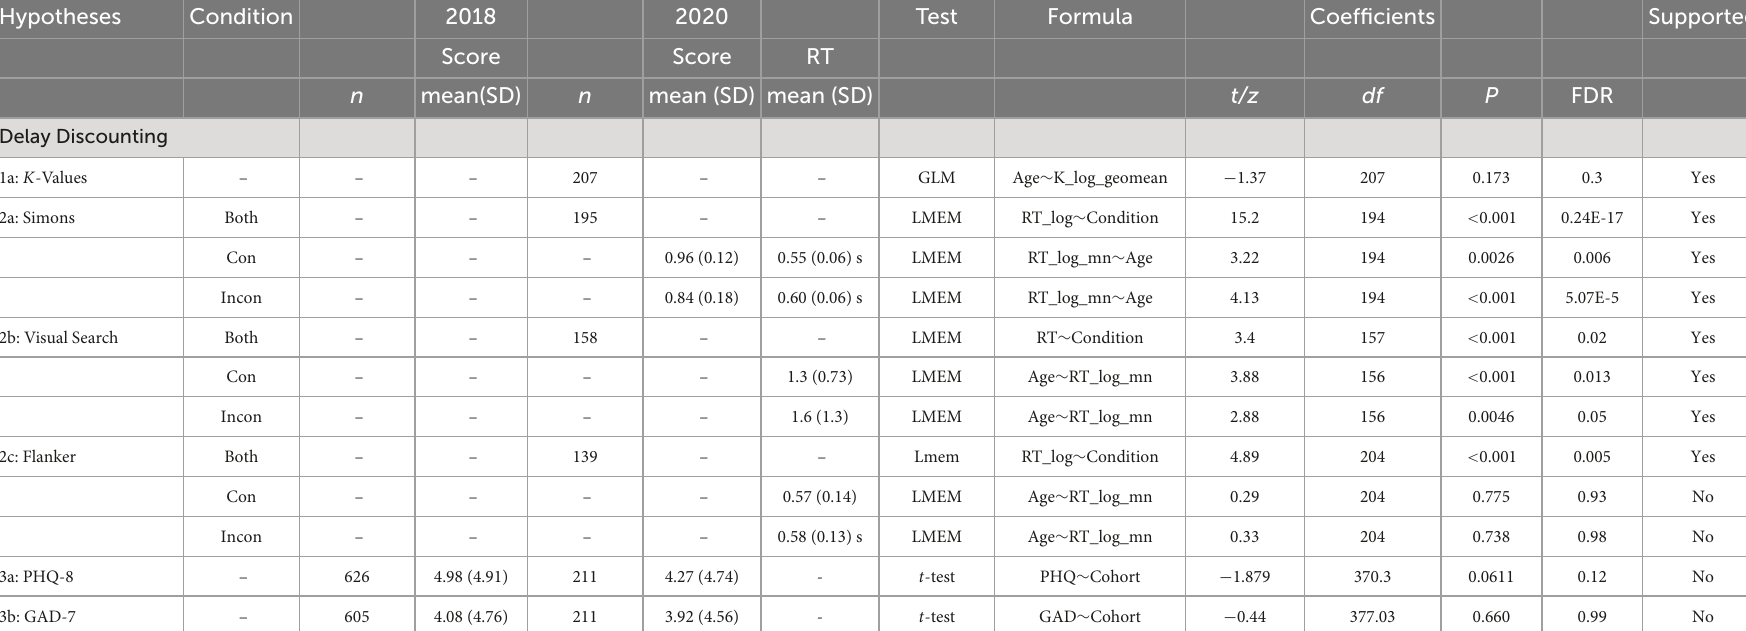
TABLE 3 Results of the pre-registered data analysis